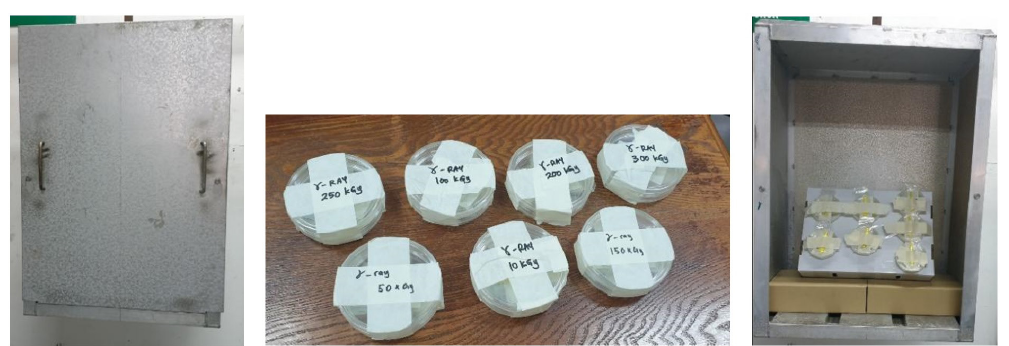
Figure 1. Experimental setup inside the gamma radiation